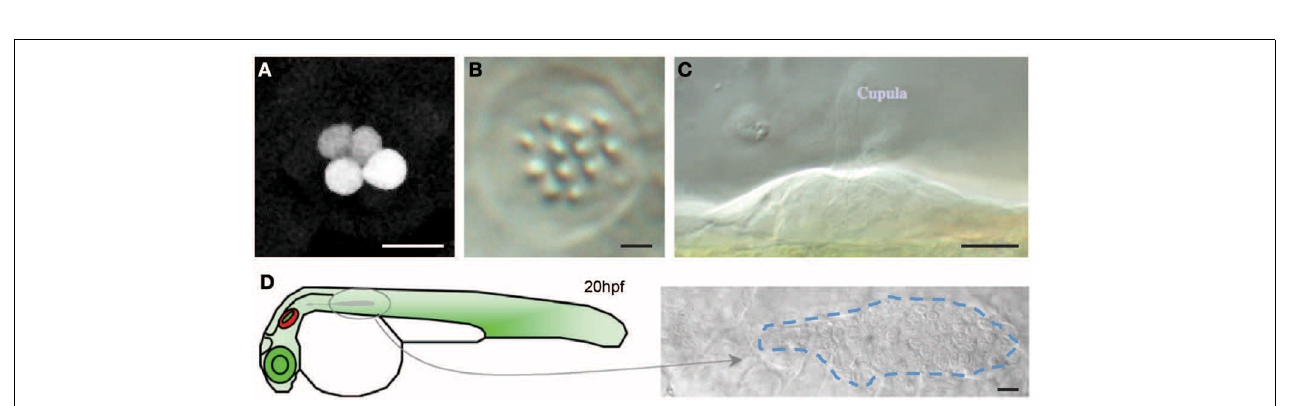
pushed down, extruding the agarose plug containing the sample from the capillary. (E) The sample is mounted on a xyz θ positioning stage in the SPIM. The laser light sheet (red) illuminates the sample along the x -axis, and the detected light (green) is collected orthogonally (along the y -axis) by the microscope optics to form an image on the camera.